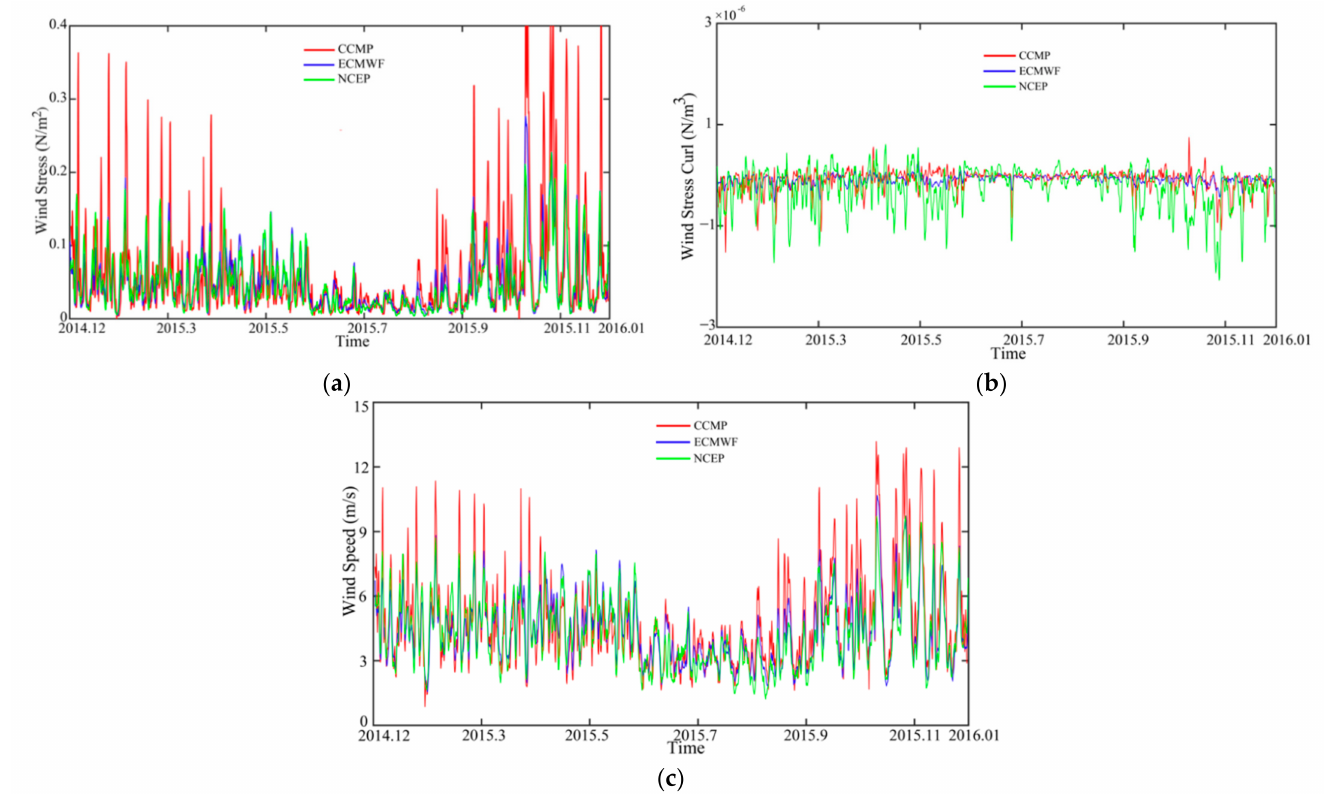
Figure 2. ( a ) The temporal evolution of the averaged wind stress, ( b ) the temporal evolution of the averaged wind stress curl, ( c ) the temporal evolution of the averaged wind speed, for the three wind fields, e.g., the CCMP, the ECMWF, and the NCEP GFS in